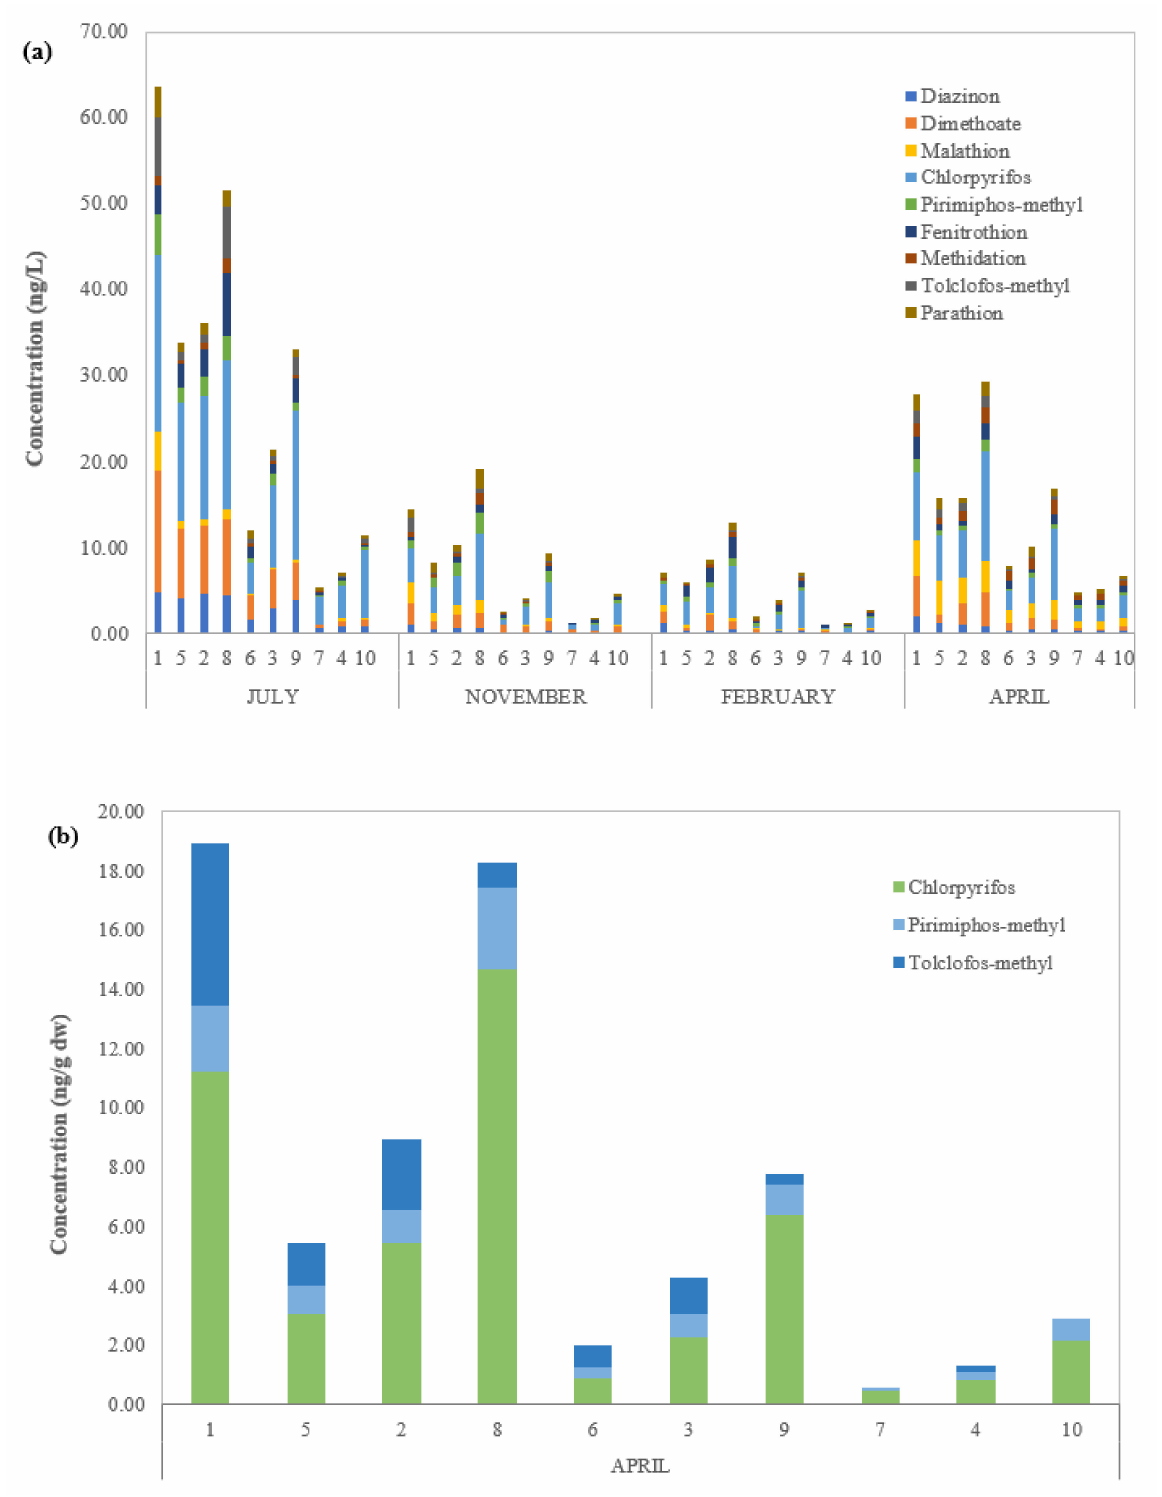
Figure 4. ( a ) Concentrations of OPPs (ng L − 1 ) detected in water (WDP+SPM) of the Sele River estuary in four seasons (July, November, February, and April) and ( b ) in sediment (SED) (ng g − 1 dry wt) in April at 10 sampling sites (1: river mouth; 2: nord estuary at 500 m; 3: nord estuary at 1000 m; 4: nord estuary at 1500 m; 5: west estuary at 500 m; 6: west estuary at 1000 m; 7: west estuary at 1500 m; 8: south estuary at 500 m; 9: south estuary at 1000 m; and 10: south estuary at 1500